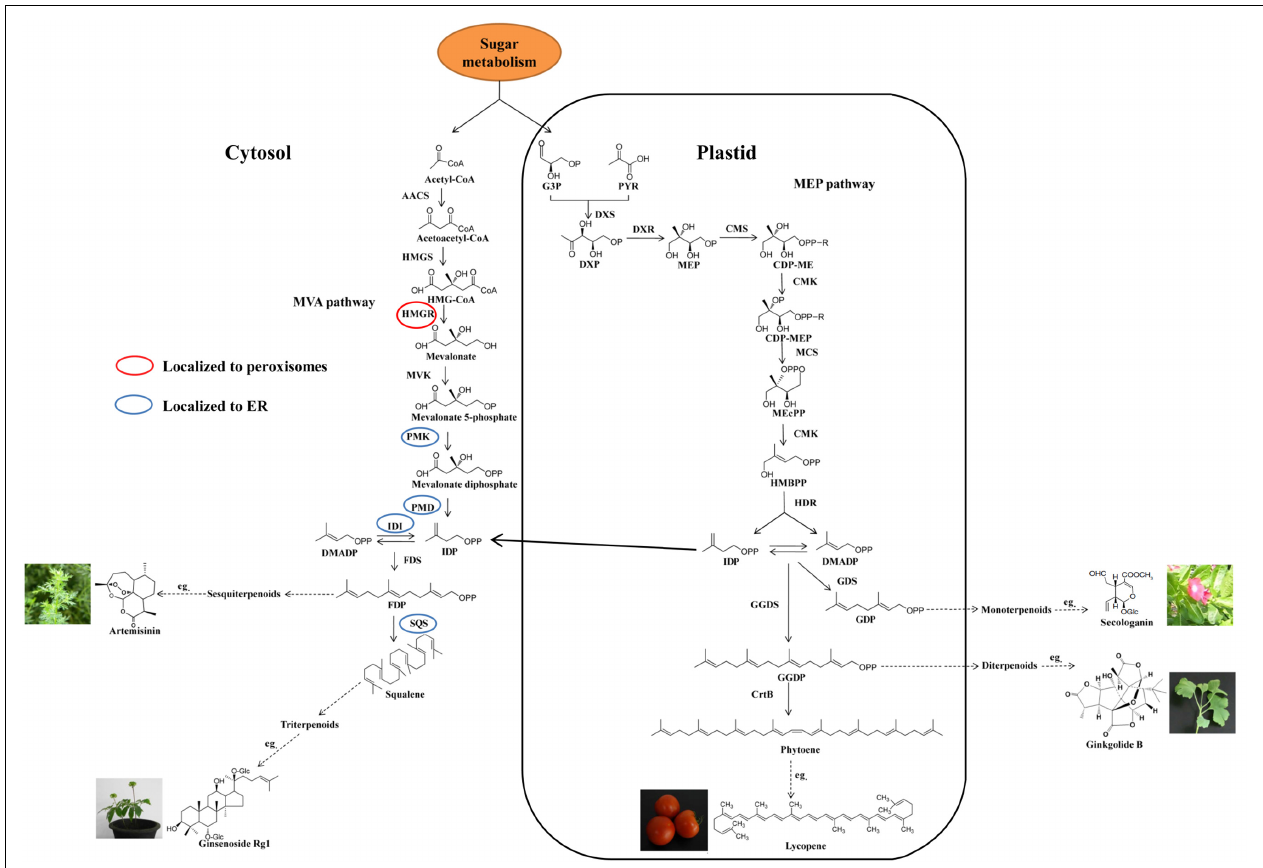
FIGURE 1 | Biosynthetic pathway of pharmaceutical terpenoids. MVA, mevalonic acid; MEP, methylerythritol phosphate; PYR, pyruvate; G3P, glyceraldehyde-3-phosphate; IDP, isopentenyl diphosphate; DMADP, dimethylallyl diphosphate; FDP, farnesyl diphosphate; GDP, geranyl diphosphate; GGDP, geranylgeranyl diphosphate; ER, endoplasmic reticulum; DXP, 1-deoxy- D -xylulose-5-phosphate; DXS, DXP synthase; MEP, 2- C -methyl- D -erythritol-4-phosphate; DXR, DXP reductase; CDP-ME, 4-diphosphocytidyl-2- C -methyl- D -erythritol; CMS, CDP-ME synthase; CDP-MEP, CDP-ME 2-phosphate; CMK, CDP-ME kinase; MEcPP, 2- C -methyl- D -erythritol-2,4-cyclodiphosphate; MCS, MEcPP synthase; HMBPP, 1-hydroxy-2-methyl-2-(E)-butenyl-4-diphosphate; HDS, HMBPP synthase; HDR, HMBPP reductase; AACS, acetoacetyl-CoA synthase; HMGS, hydroxymethylglutaryl (HMG)-CoA synthase; HMGR, HMG-CoA reductase; MVK, mevalonate kinase; PMK, phosphomevalonate kinase; PMD, mevalonate diphosphate decarboxylase; IDI, isopentenyl diphosphate isomerase; GDS, geranyl diphosphate synthase; FDS, farnesyl diphosphate synthase; GGDS, geranylgeranyl diphosphate synthase; SQS, squalene synthase; CrtB, phytoene